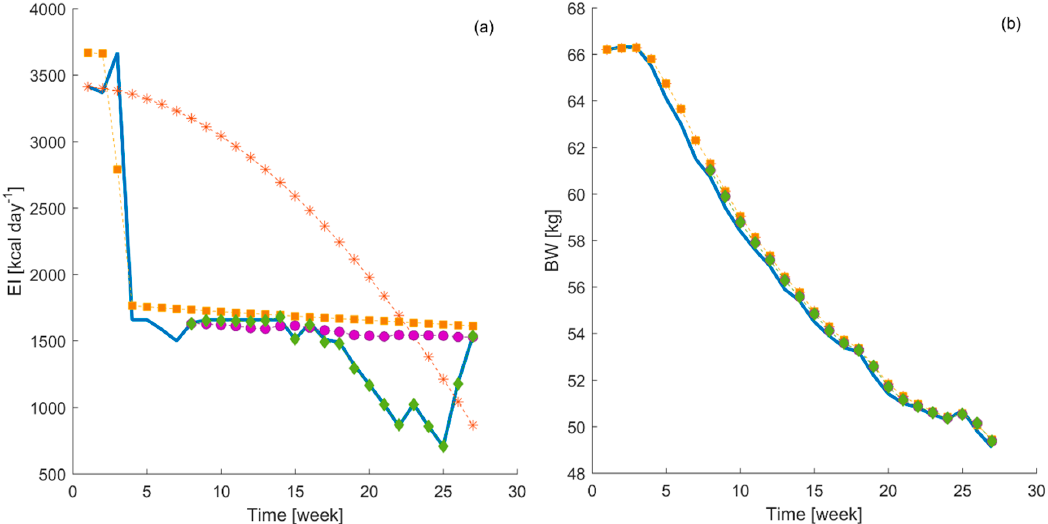
Figure 4. In ( a ), the energy intake curves suggested by the model predictive control (MPC) (dashed colored lines) compared with the energy intake measured (solid blue line) during the Minnesota starvation experiment are shown for participant 15. In ( b ), the bodyweight time course obtained following the MPC suggestions (dash colored lines) compared with the bodyweight measured (solid blue line) during the Minnesota starvation experiment is shown for participant 15. The different MPCs tested are the MPC using a time-invariant parameters transfer function model, without (red - *) and with constraints (yellow - square), and the MPC using the time-variant parameters DARX model, without (purple circle) and with constraints (green diamond).